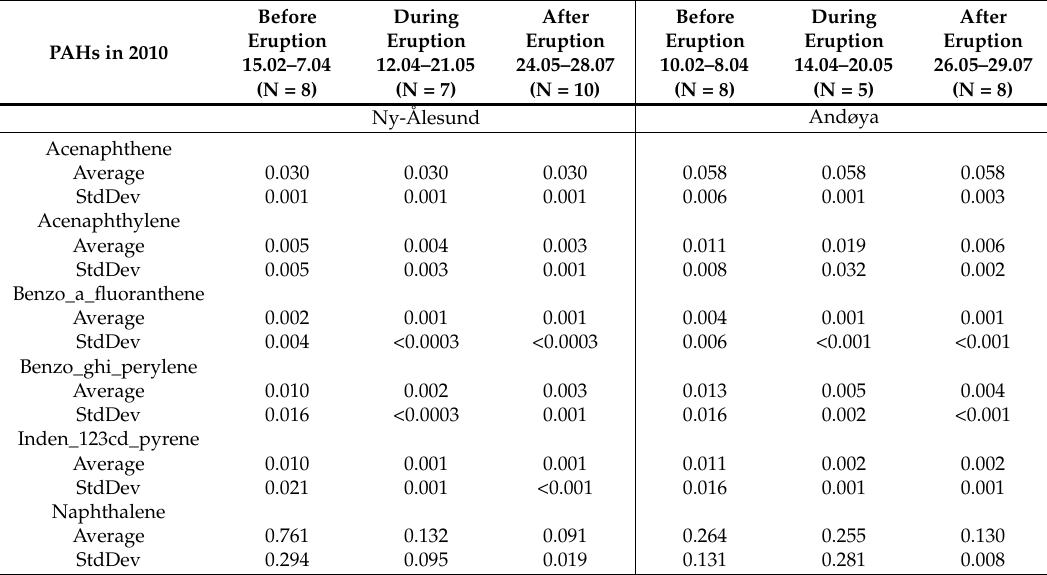
Table 6. Average concentration and standard deviation of selected PAHs (ng ∙ m − 3 ) in the atmospheric air collected once a week from the stations included in EBAS Data Centre (NO0042G Zeppelin Mountain (Ny ‐ Ålesund) and NO0090R Andøya) before, during and after the Eyjafjallajökull eruption in 2010 (based upon data available on EBAS Data Centre[52]).